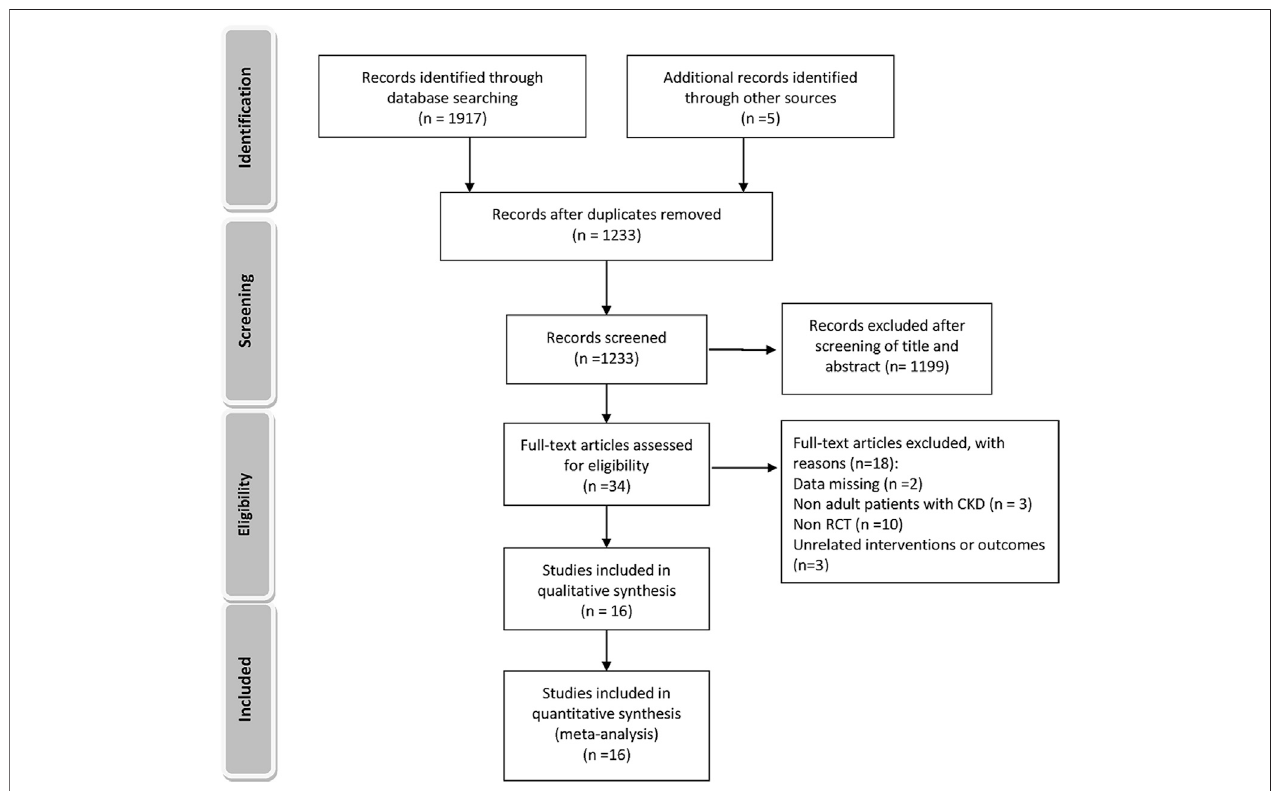
FIGURE 1 | Flowchart of the study selection